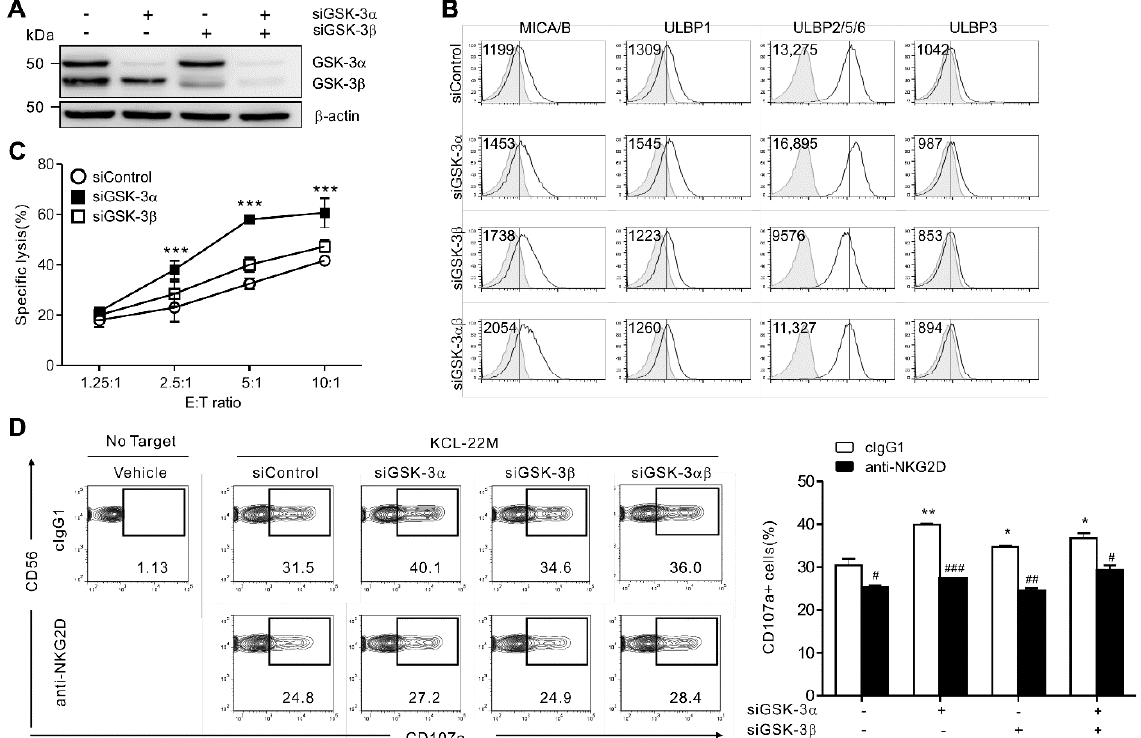
Figure 2. GSK-3 α selectively regulates NKG2DL expression on TKI-resistant KCL-22M cells and their cytolysis by NK cells. ( A ) Total cell lysates of KCL-22M cells transfected with control siRNA or siRNAs specific for GSK-3 α and/or GSK-3 β for 48 h were immunoblotted for GSK-3 α / β and actin. ( B ) After siRNA-mediated knockdown, KCL-22M cells were analyzed for the surface expression of NKG2DL (MICA/B, ULBP1, ULBP2/5/6, and ULBP3) by flow cytometry. ( C ) NK cell cytotoxicity against KCL-22M cells depleted of GSK-3 α and/or GSK-3 β was assessed using a europium-based cytotoxicity assay with expanded primary NK cells at the indicated effector to target (E:T) cell ratios. ( D ) Degranulation of NK cells against KCL-22M cells depleted of GSK-3 α and/or GSK-3 β was measured using expanded primary NK cells in the absence or presence of NKG2D blockade. Representative flow cytometry profile (left) and summary graph (right) demonstrating the percentage of CD107a + on CD3 − CD56 + NK cells. Values represent the means ± s.d. Data are representative of at least three independent experiments. * ,# p < 0.05; ** ,## p < 0.01; *** ,### p <